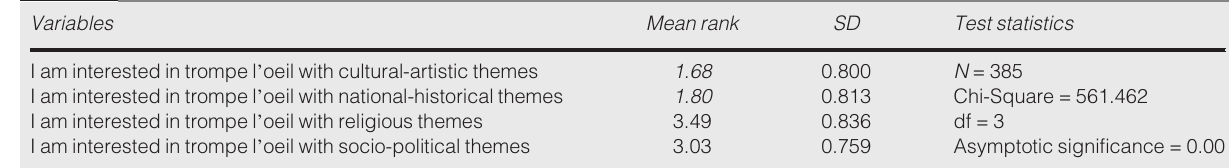
Table 5 The output of the Friedman test for the investigation of priority of religious, social, political and cultural themes for trompe l ’ oeil from the tourists ’ perspective Variables